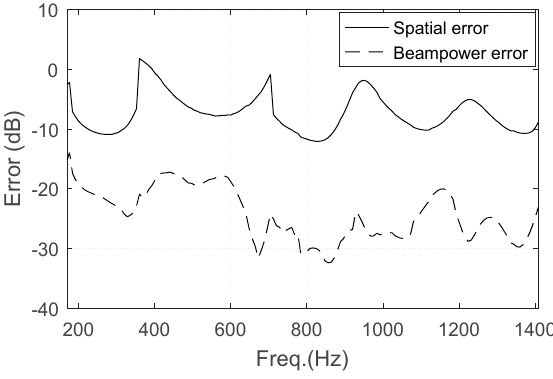
Figure 8. Spatial error and beam-power error in the pre-experiment.